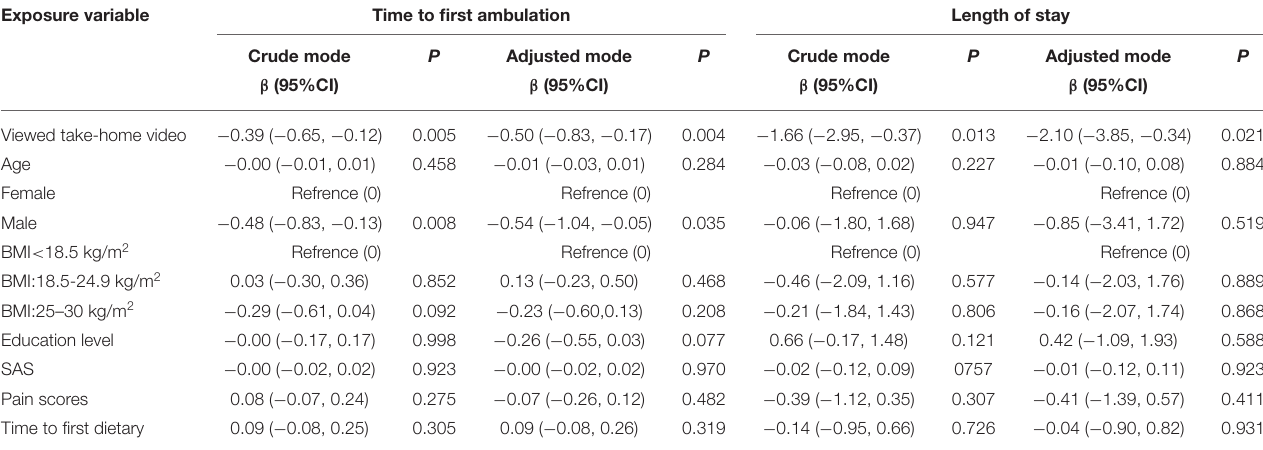
TABLE 3 | Relationship between exposure variable and the time to first ambulation and length of stay(h). Exposure